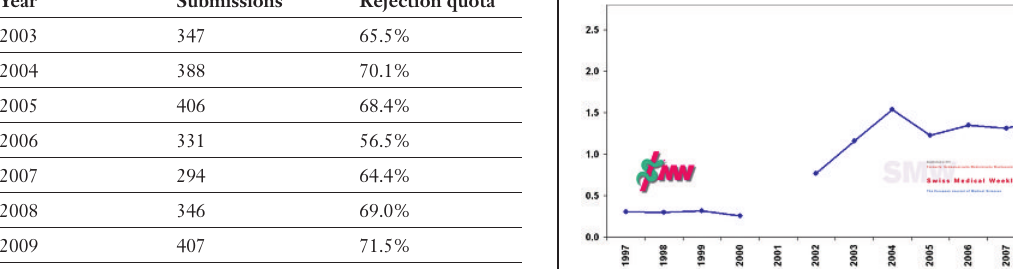
Submissions and rejection quota Swiss Medical Weekly.